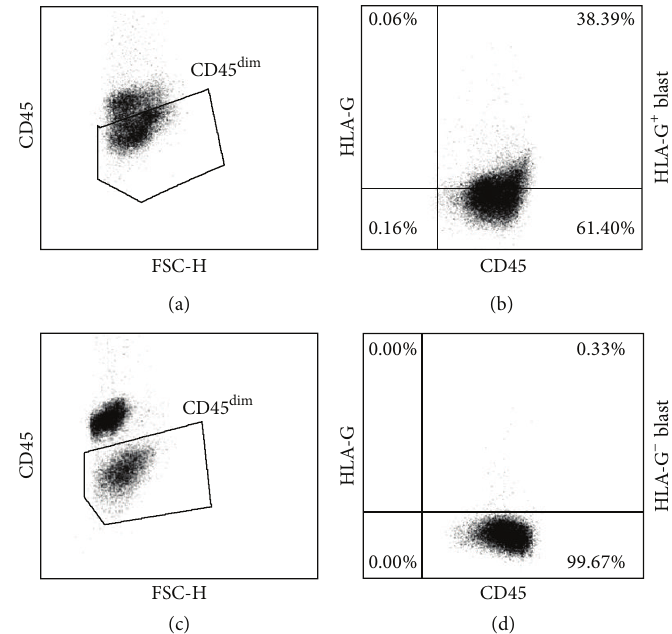
Figure 1: HLA-G expression on leukemic blasts. PBMCs of AML patients were analyzed by flow cytometry to determine the expression of HLA-G on blasts. An anti-human CD45 mAb was used to discriminate leukemic cells from normal mononuclear cells, being blasts CD 45 dim . Representative plots from a patient with HLA-G + blast ((a) and (b)) or with HLA-G − blast ((c) and (d)) are shown.